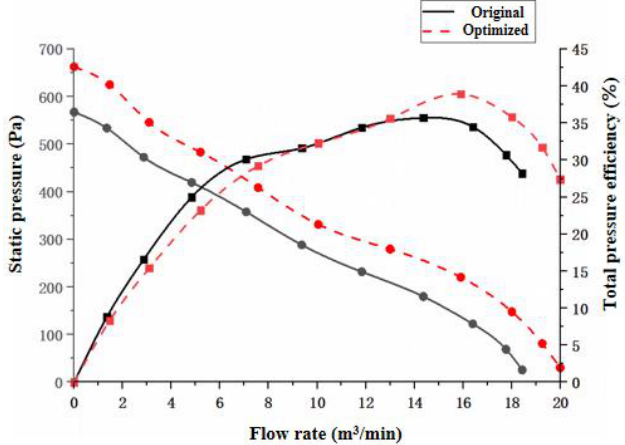
Figure 20. Comparison of fan performance curves before and after optimization.